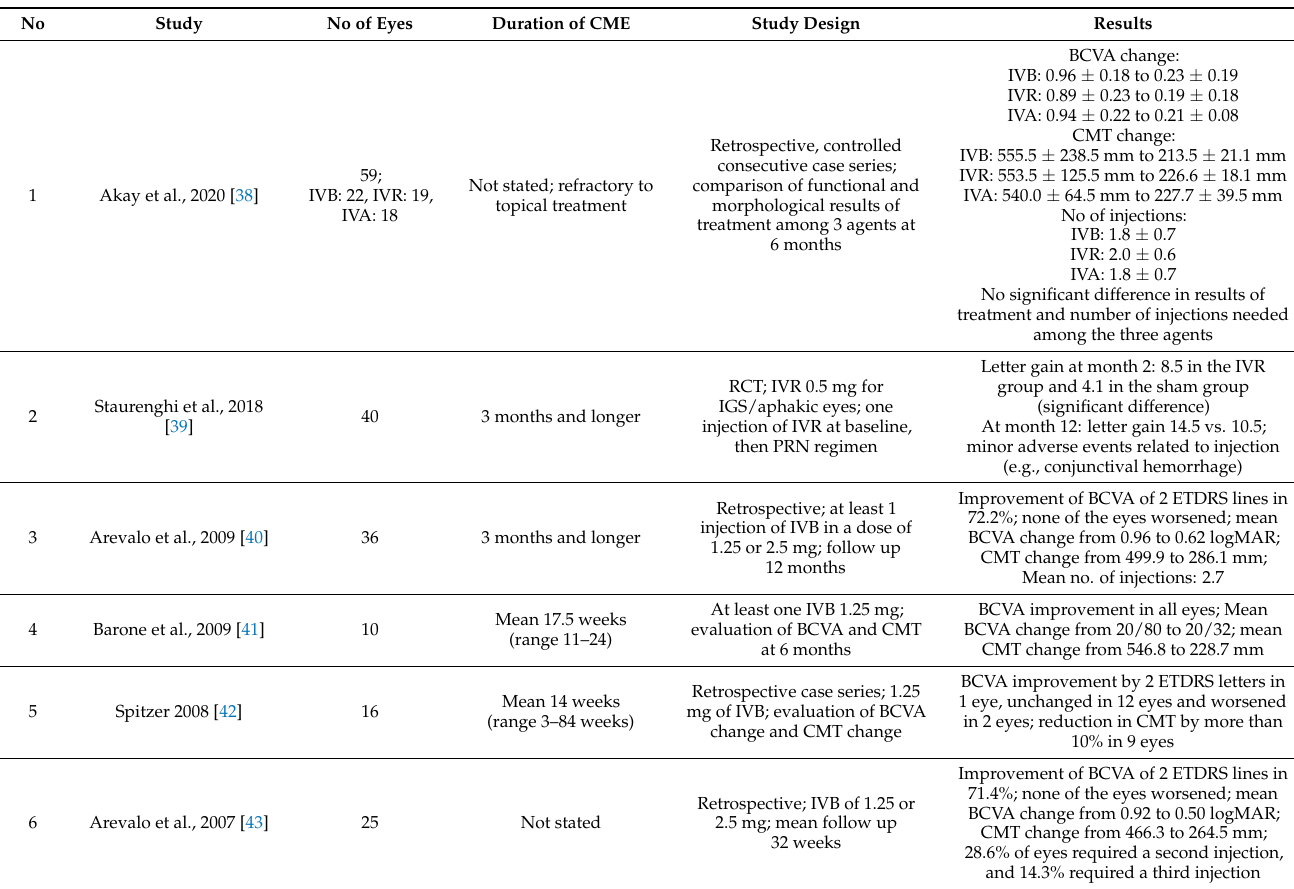
Table 6. Results of the studies analyzing the efficacy of intravitreal anti-VEGF agents in the treatment of IGS that involved at least 10 cases and were published since